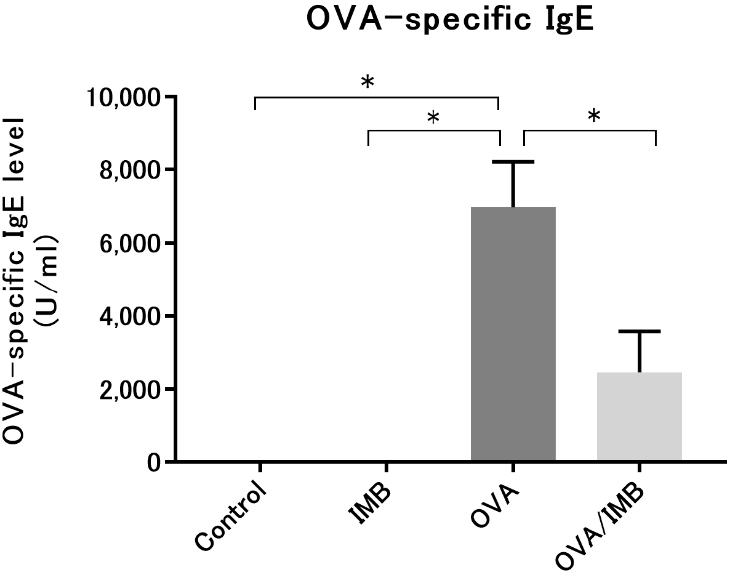
Figure 9. Serum IgE levels were significantly attenuated by ImmuBalance treatment. Values represent the mean ± standard error of the mean. * p < 0.05.